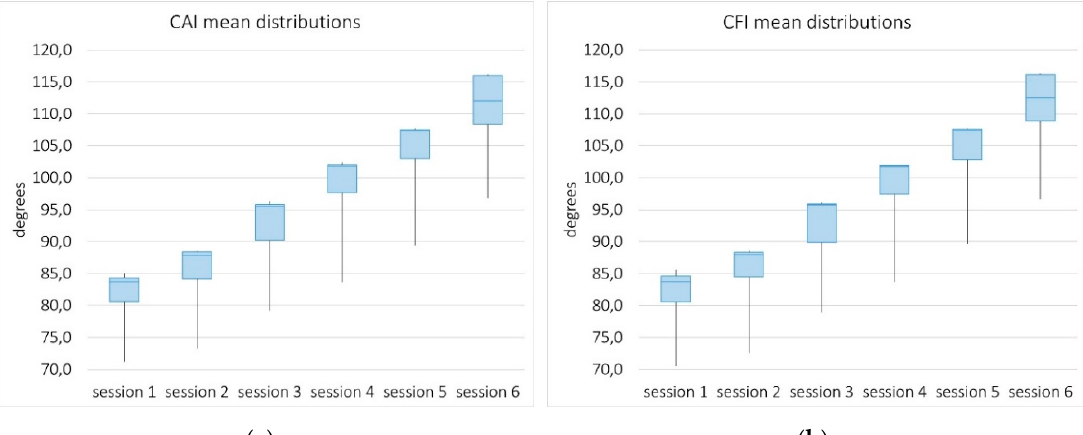
Figure 9. Box plots from distributions of the mean values of the Concentric Abduction Index ( a ) and the Concentric Flexion Index ( b ) across patients over the six sessions. These measures ranges from 0 to 120º, with the latter being the goal established in this study.